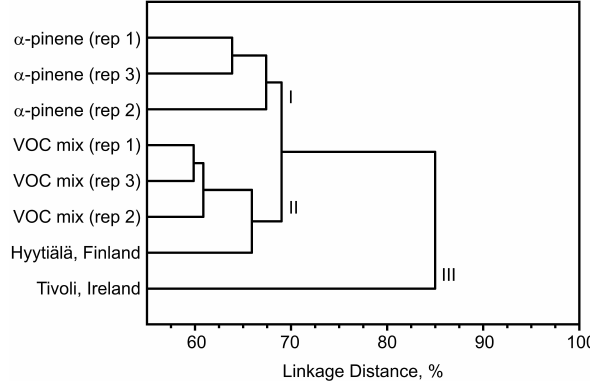
Fig. 7. Tree diagram derived from hierarchical cluster analysis (HCA) of ambient and laboratory-generated samples (unweighted pair-group average linkage method). The linkage distance between two samples, expressed in percentage, has been calculated as the difference between the total ions considered in the cluster analy- sis (451 ions, 100%) and the number of common ions between the samples (see text for detailed explanation). Rep 1, 2 and 3 corre- spond to chamber replicate